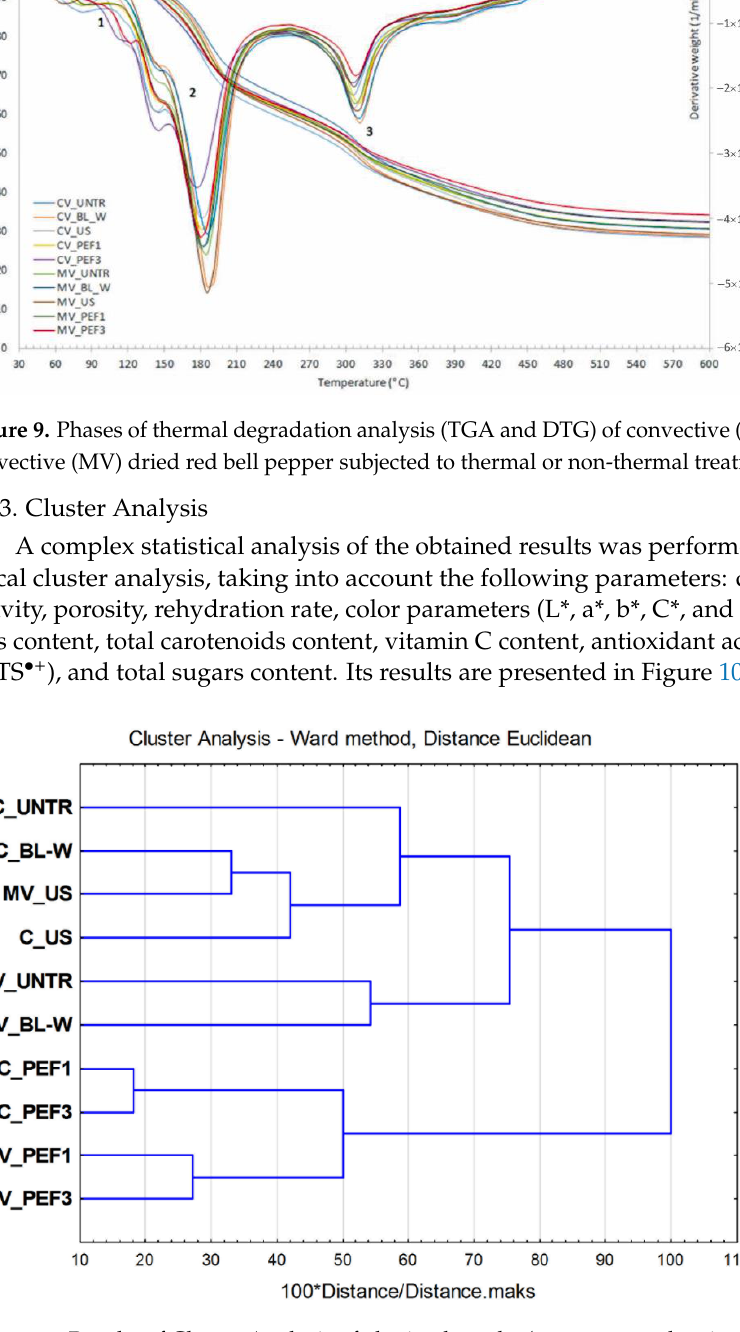
Figure 10. Results of Cluster Analysis of obtained results (parameters taken into account: TPC, TCC, vitamin C, DPPH, ABTS, sugars, L*, a*, b*, C*, ∆ E, water activity, porosity, rehydration ratio, and drying time). C—convective drying, MV—microwave-assisted convective drying, UNTR—untreated, BL-W—blanched, US—ultrasound, PEF1—pulsed electric field treatment at 1 kJ/kg, PEF3—pulsed electric field treatment at 3